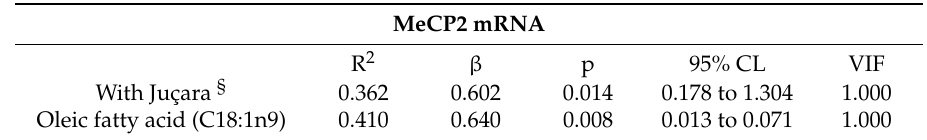
Table 6. Multiple linear regression analysis of the monocytes MeCP2 mRNA levels with juçara treatment and with oleic fatty acid serum concentration.